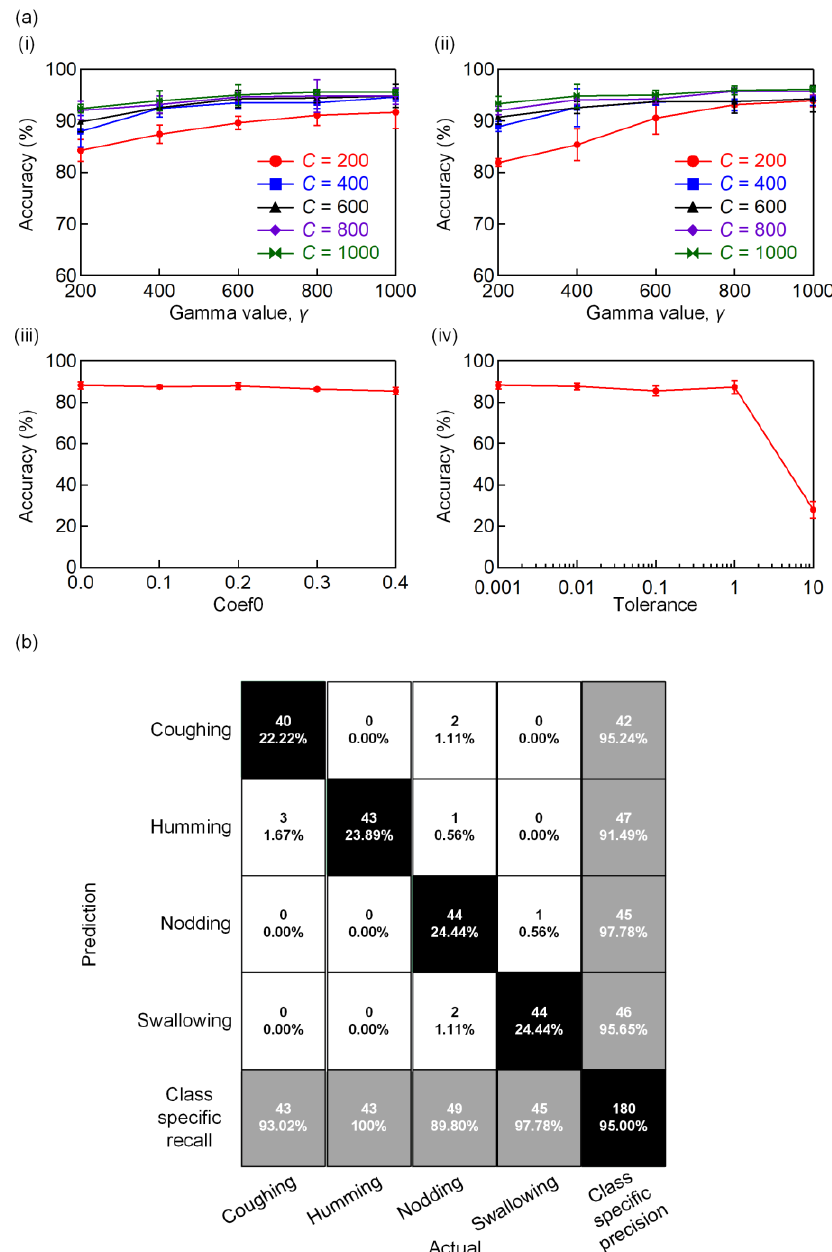
Figure 7. ( a ) Accuracies of the SVM models with different values of C and γ using ( i ) linear kernel and ( ii ) radial basis function kernel. ( iii ) Coef0 as a function of accuracy and ( iv ) tolerance as a function of accuracy. ( b ) Confusion matrix of the optimized SVM model.